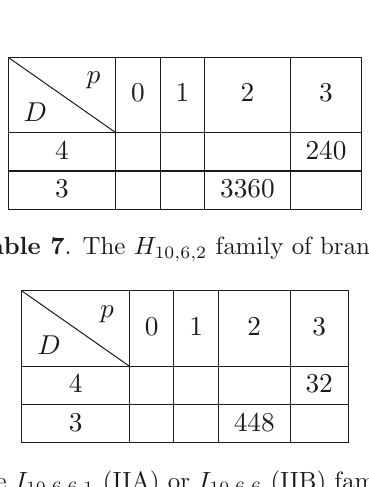
Table 8 . The I 10 , 6 , 6 , 1 (IIA) or I 10 , 6 , 6 (IIB) family of